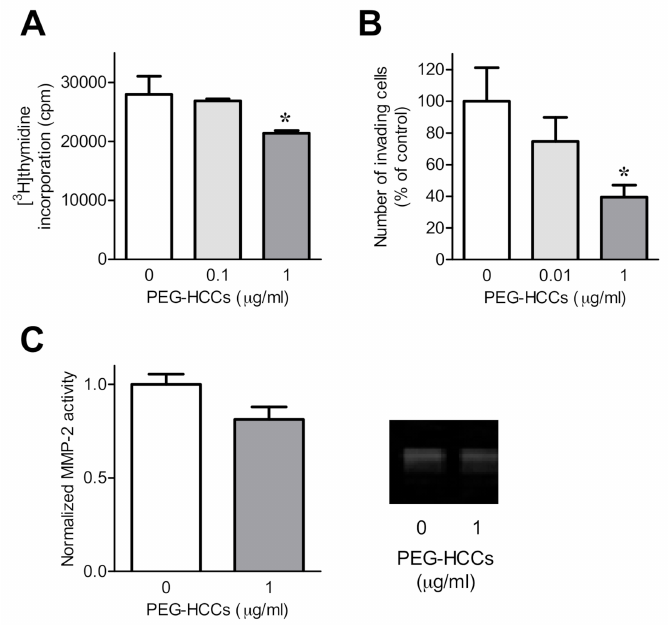
Figure 2. PEG-HCCs reduce RA-FLS invasion and proliferation. ( A ) Proliferation of RA-FLS treated with 0, 0.1, or 1 µ g / mL PEG-HCCs for 72 h ( n = 3). ( B ) Invasion through Matrigel-coated transwell inserts of RA-FLS in the presence of 0, 0.01, or 1 µ g / mL PEG-HCCs ( n = 3). Representative images are shown in Supplemental Figure S2. ( C ) Left, matrix metalloproteinase-2 (MMP-2) secretion of RA-FLS treated with or without 1 µ g / mL PEG-HCCs for 24 h ( n = 7). Right, example zymography gel of supernatants of RA-FLS treated with or without 1 µ g / mL PEG-HCCs for 24 h. * p < 0.05. Data are presented as mean ±